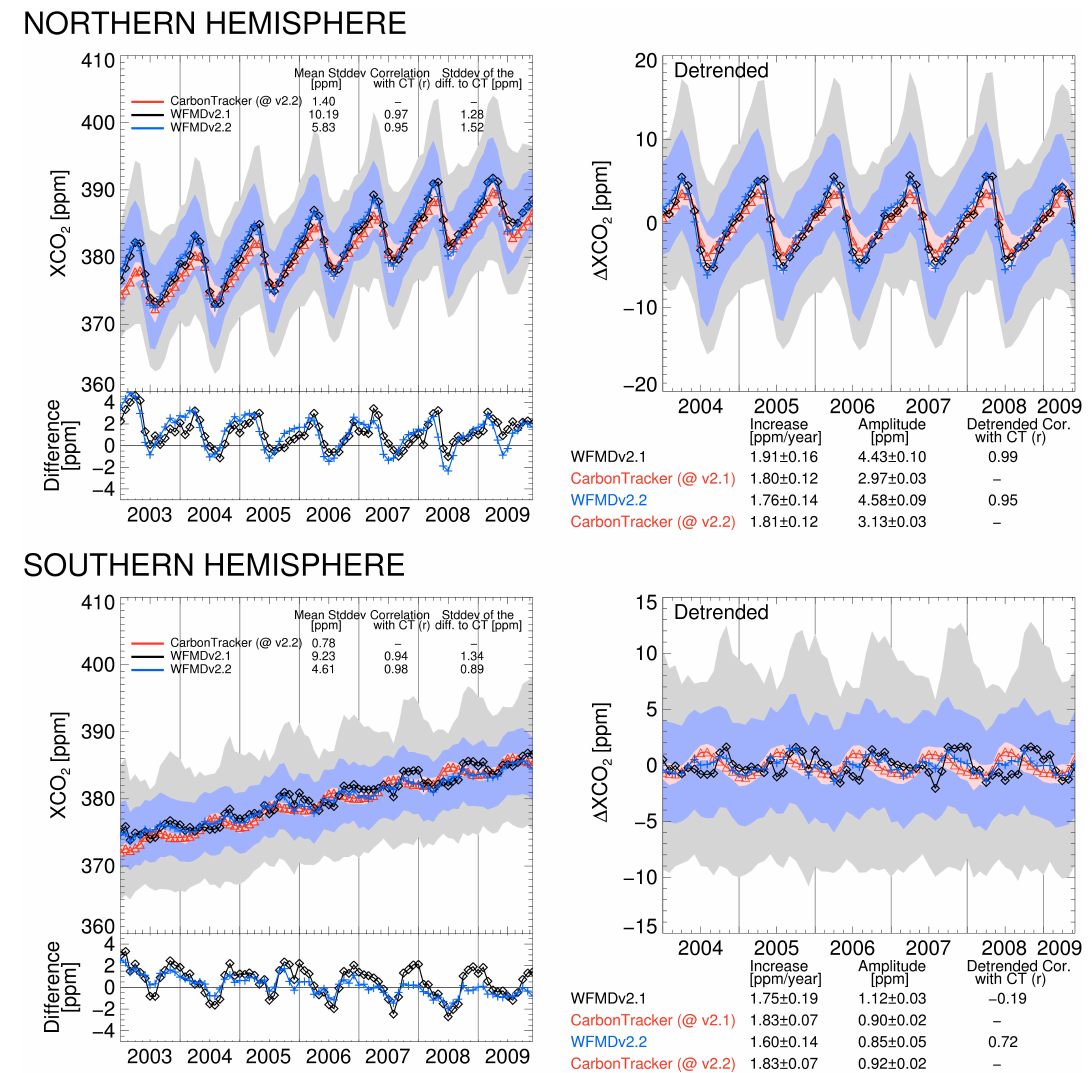
Fig. 9. Comparison of SCIAMACHY WFM-DOAS version 2.1 (WFMDv2.1) and 2.2 (WFMDv2.2) with CarbonTracker X CO 2 for the Northern (top) and Southern (bottom) Hemisphere for the years 2003–2009. CarbonTracker was sampled as WFMDv2.1 (@v2.1) for the comparison with WFMDv2.1 and sampled as WFMDv2.2 (@v2.2) for the comparison with WFMDv2.2. Top: The left panel shows the time series of monthly means of WFMDv2.1 (black diamonds), WFMDv2.2 (blue crosses) and CarbonTracker (red triangles) X CO 2 and the difference to CarbonTracker for the Northern Hemisphere. The shaded areas represent the monthly standard deviations of WFMDv2.1 (grey), WFMDv2.2 (light blue) and CarbonTracker (red). In addition, the averaged monthly standard deviation, the correlation with CarbonTracker and the standard deviation of the difference to CarbonTracker are shown. The right panel shows the detrended time series. Furthermore, the annual increase, the seasonal cycle amplitude and the detrended correlation (correlation between the detrended satellite time series and CarbonTracker) are shown. Bottom: as in top panels but for the Southern